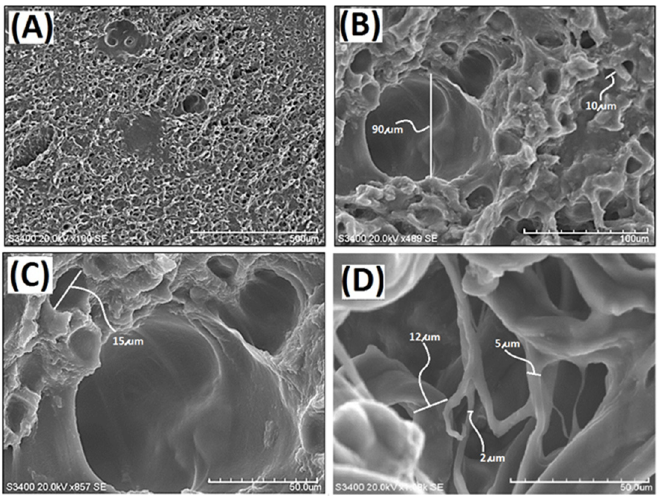
Figure 1. Scanning electron micrographs of the decellularized elastic cartilage microscaffold, PCFM0N: ( A ) PCFM0N membrane (scale bar 500 μ m), ( B ) PCFM0N membrane (scale bar 100 μ m), ( C ) PCFM0N membrane (scale bar 50 μ m), and ( D ) PCFM0N powder (scale bar 50 μ m).